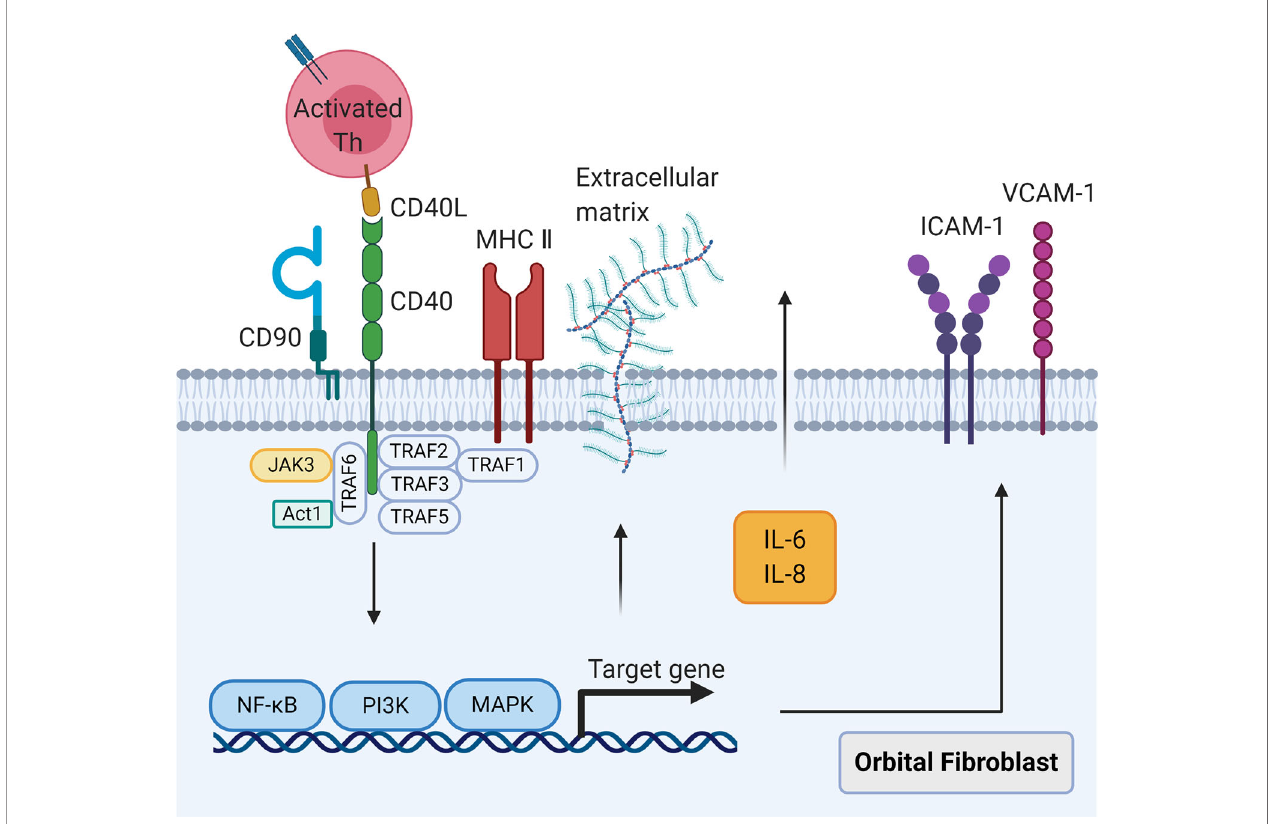
FIGURE 2 | The CD40-CD40 ligand signaling in orbital fi broblasts. When CD40 ligand on self-reactive T cells combines with CD40 on orbital fi broblasts, the nuclear translocation of nuclear factor- k B, mitogen activated protein kinases, and phosphatidylinositol-3-kinase signaling pathways will be activated, leading to the synthesis of cytokines interleukin-6 and interleukin-8, costimulatory molecules intercellular adhesion molecule-1 and vascular cell adhesion molecule-1, and extracellular